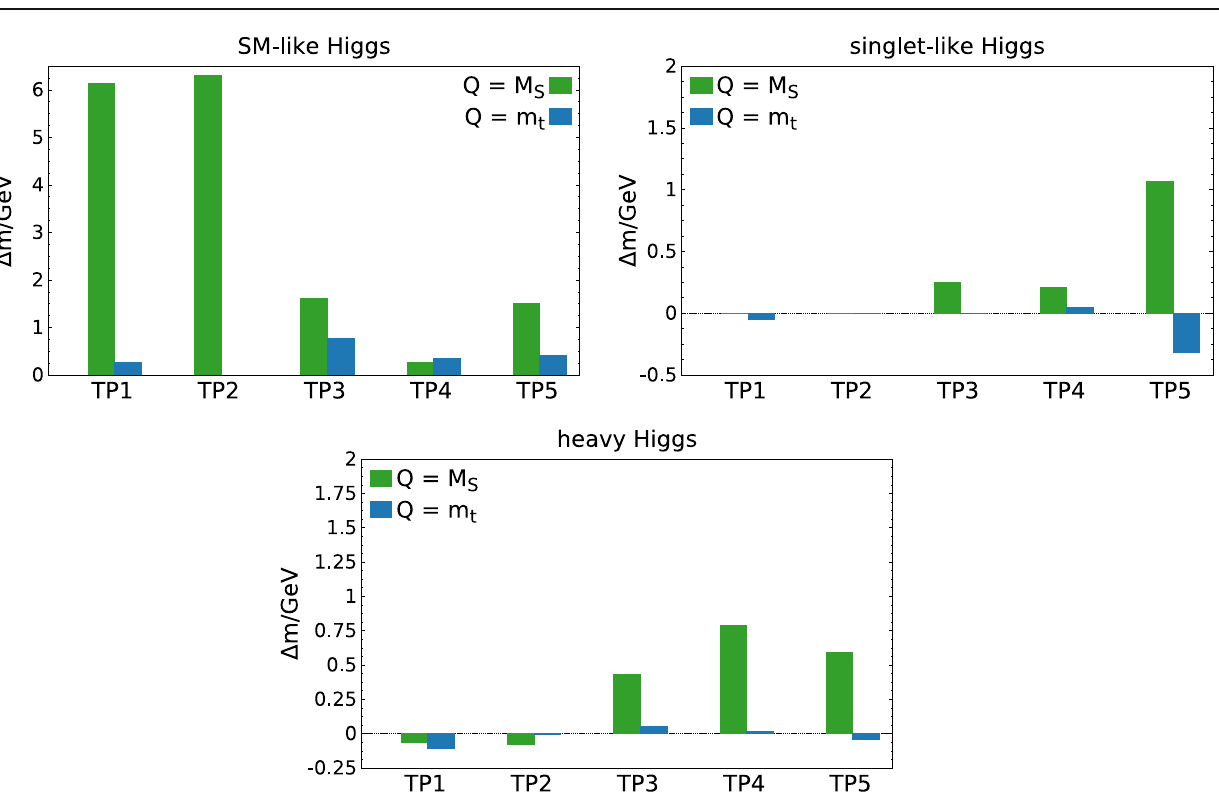
− M N-FH Fig. 2 Difference (cid:9) m = M NC between the predicted Higgs masses of the SM-like, singlet-like and heavy Higgs at the two-loop level h h calculated at the scales M S and m